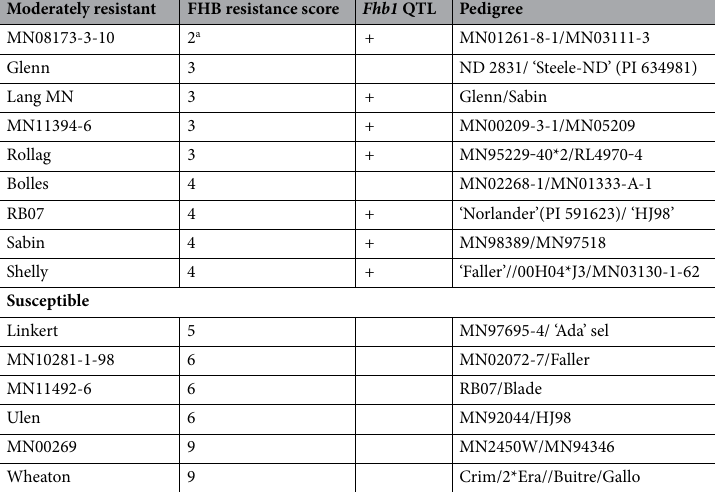
The impact of elevated CO 2 on grain quality is cultivar dependent, and even known adaptive traits, such as high nitrogen use efficiency and improved root vigor, are not sufficient to counteract the effects on grain protein and recover end-use quality 19,20 . The effects of rising CO 2 not only impacts wheat nutritional content but can also